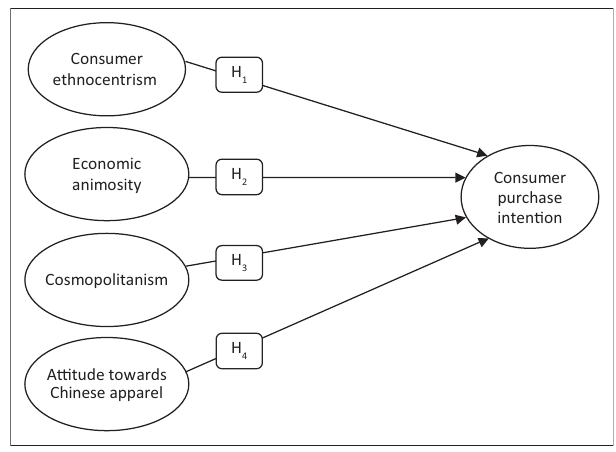
FIGURE 3: Alternative Model